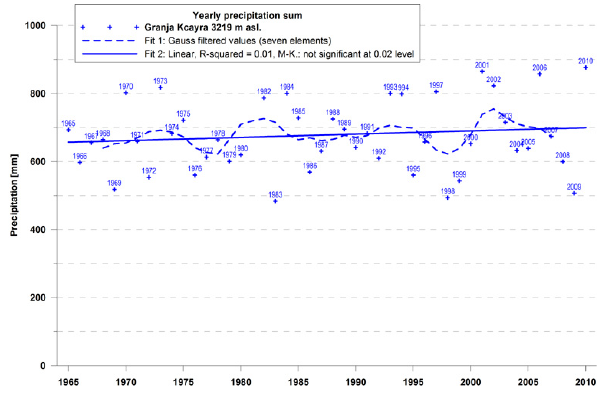
Figure 11. Yearly precipitation sum and linear and gaussian low- pass filtered trends for the homogeneous time series of Granja Kcayra ( − 13.56 ◦ S, − 71.88 ◦ E, 3219ma.s.l.). Linear trend between 1965 and 2010 is not significant at the 0.02 level with Mann-Kendall